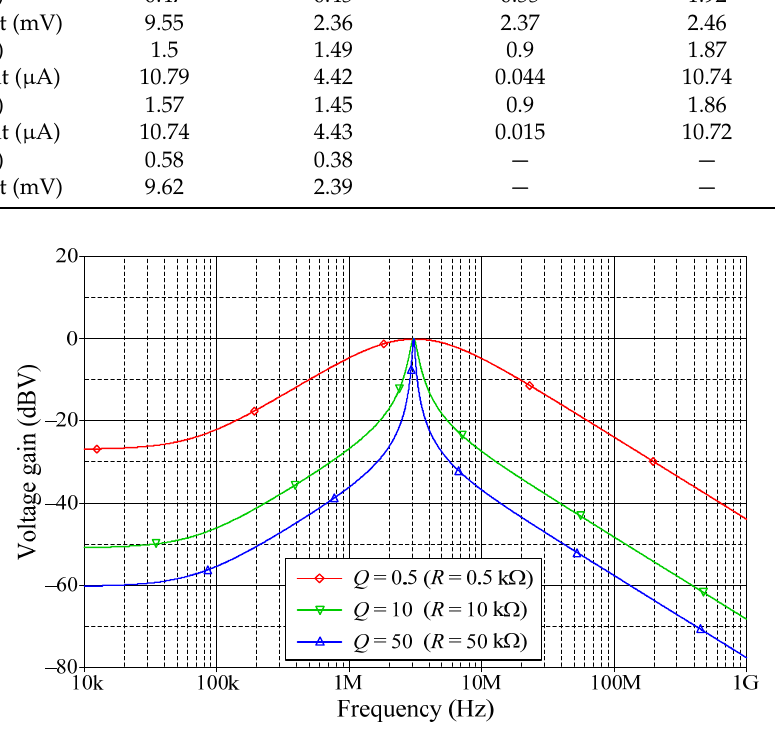
Figure 14. Tunability of Q with f o unchanged for BP filter in VM.